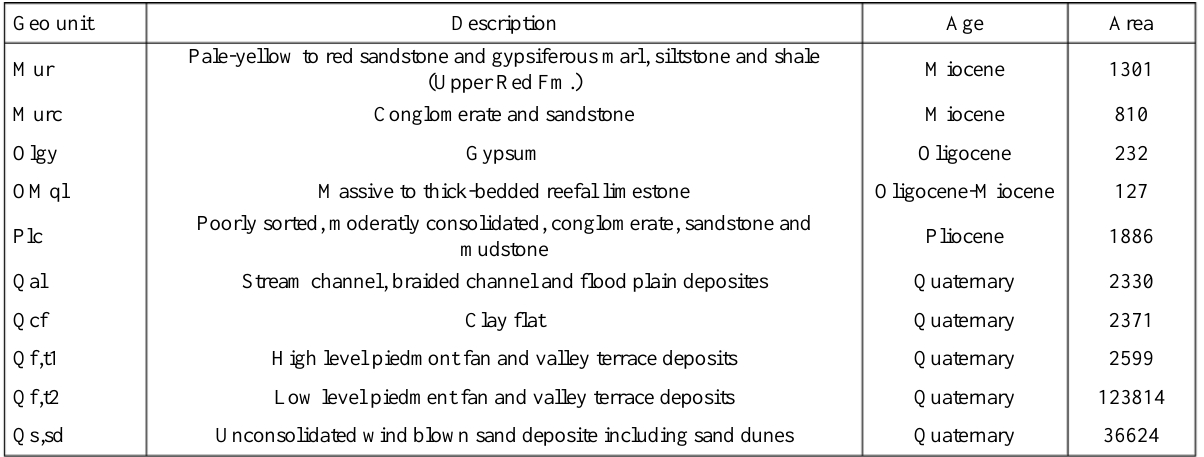
Table 2. Lithology of the study area.